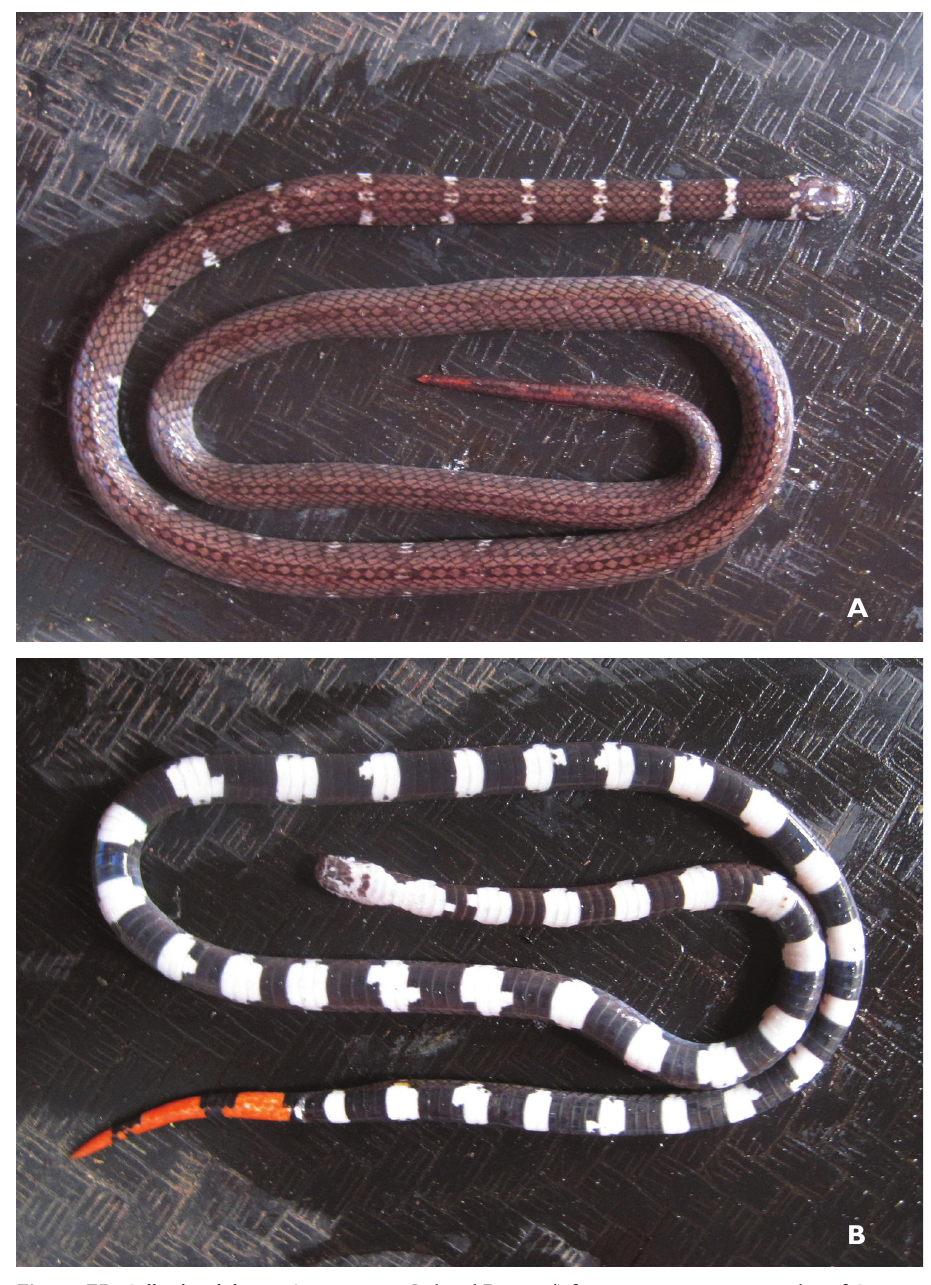
Figure 75. Calliophis philippina (KU 320005; A dorsal B ventral) from Mt. Lumot, Municipality of Gingoog City, Misamis Oriental Province. Photo: